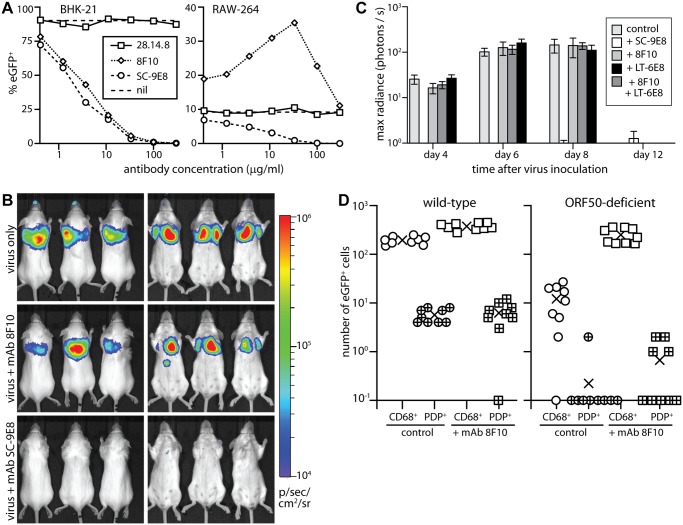
Neutralization of lung infection.
A. EGFP+ MuHV-4 (EF1α-eGFP) was incubated with mAb SC-9E8 (IgG2a, anti-gB), 8F10 (IgG2a, anti-gH/gL) or 28.14.8 (IgG2a, anti-mouse H2Db, negative control). nil = no antibody. After 2h at 37°C, each virus preparation was split between BHK-21 fibroblasts (1 p.f.u./cell) and RAW-264 monocytes (5 p.f.u./cell). The cells were cultured overnight with phosphonoacetic acid (100μg/ml) to prevent lytic spread, then analyzed for eGFP expression by flow cytometry. Each point shows %eGFP+ of 10,000 live cells. 8F10 significantly increased RAW-264 infection at each dilution and SC-9E8 significantly reduced it (p<10-6 by Fisher's exact test, counting eGFP+ and eGFP- cells for 8F10 and the negative control). B. Luciferase+ MuHV-4 was incubated or not (virus only) with mAb SC-9E8 or 8F10 (100μg/105 p.f.u.), then given i.n. (103 p.f.u.) to BALB/c mice. Infection was tracked by live imaging. The images show example mice at day 4, with luciferase signals in color. C. Luciferase+ MuHV-4 was incubated as in b with SC-9E8, 8F10, and no antibody (control) or with mAb LT-6E8 (IgG2b, anti-gp70) or LT-6E8 + 8F10. Bars show mean ± SEM of 6 mice per group tracked serially by live imaging. At days 4, 6 and 8, SC-9E8-coated virus gave significantly lower signals than the controls (p<10-6 by Student’s 2-tailed unpaired t test). The signals with 8F10, LT-6E8, and 8F10 + LT-6E8 were no different to the control (p>0.3). D. ORF50+ or ORF50- eGFP+ MuHV-4 was coated or not (control) with mAb 8F10 (100μg/105 p.f.u.) then given i.n. (104 p.f.u.) to C57BL/6 mice. 1 day later lung sections were stained for eGFP, PDP and CD68. EGFP+ cells co-localizing with either cell marker were counted on 9 sections from 3 mice. Crosses show means, other symbols show individual section counts. Incubation with mAb 8F10 increased significantly the number of eGFP+CD68+ cells for both WT and ORF50- viruses (p<10-5) but not the number of eGFP+PDP+ cells (p>0.3).